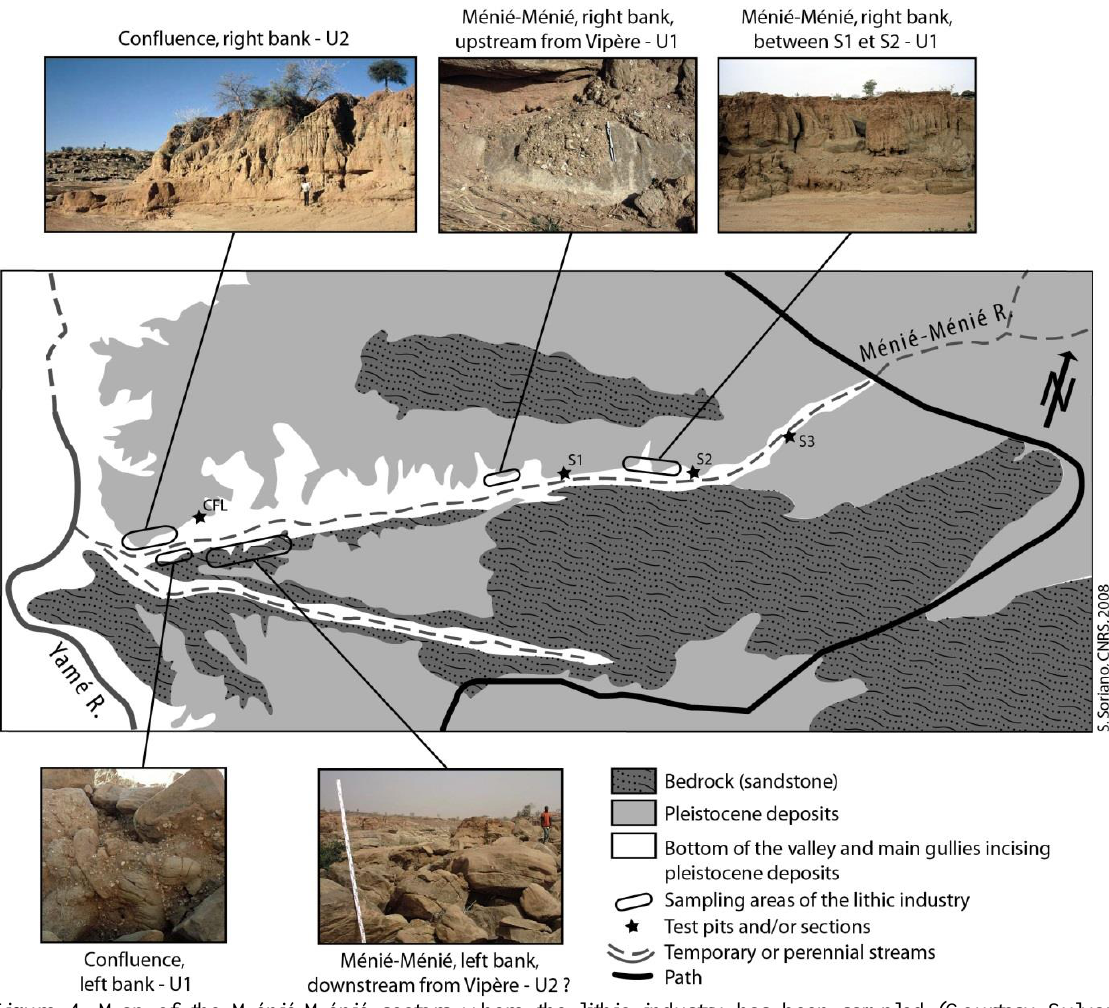
Figure 4. Map of the Ménié-Ménié sectors where the lithic industry has been sampled (Courtesy Sylvain Soriano, Mission archéologique